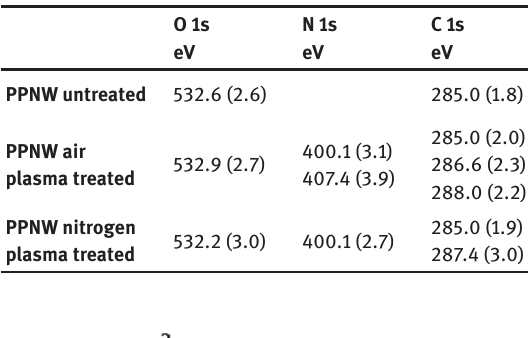
Table 2: Characteristic peak energies for the untreated and plasma- treated polypropylene sample (peak width in parentheses).